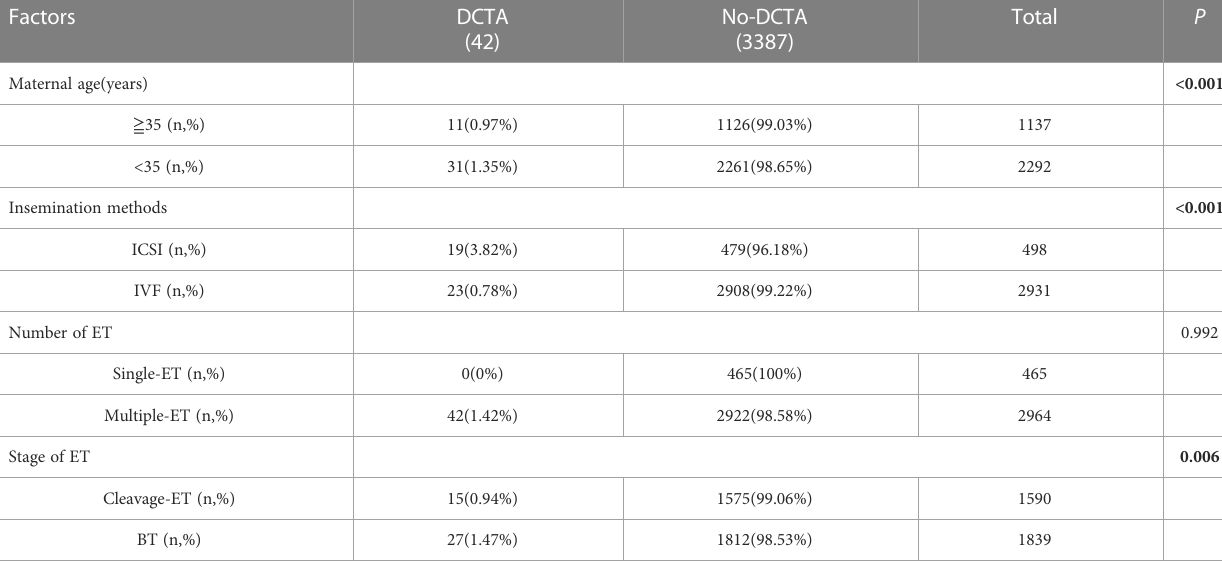
TABLE 2 Risk factors of DCTA in the fresh ET cycle by multivariate logistic regression analyses. Factors